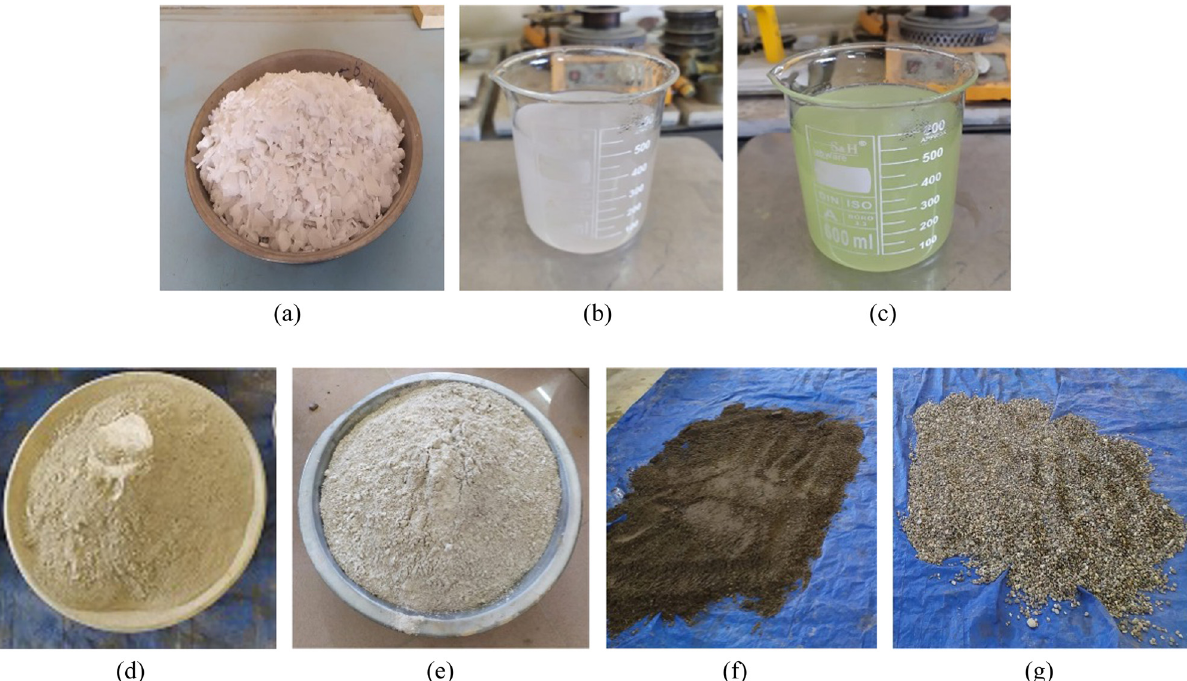
Figure 1: Materials used in the production of SCGC specimens: ( a ) sodium hydroxide, ( b ) alkaline solution, ( c ) superplasticizer, ( d ) FA, ( e ) GGBFS, ( f ) fi ne aggregate, and ( g ) coarse